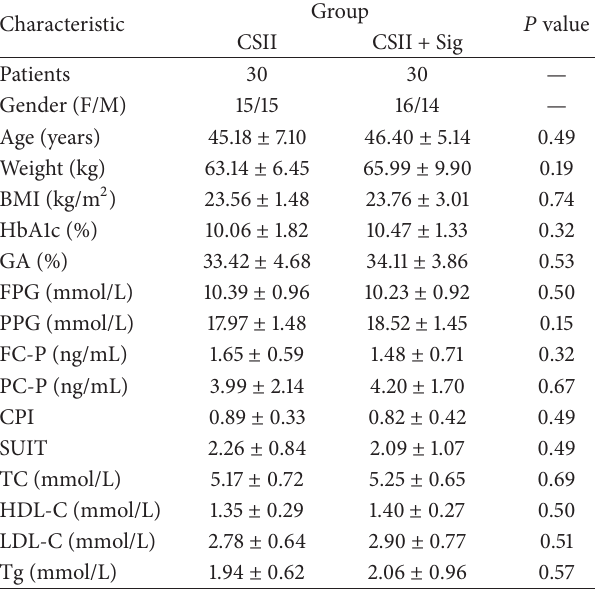
Table 2: Glycemic variability between the CSII and CSII + Sig groups after the suspension of continuous subcutaneous insulin